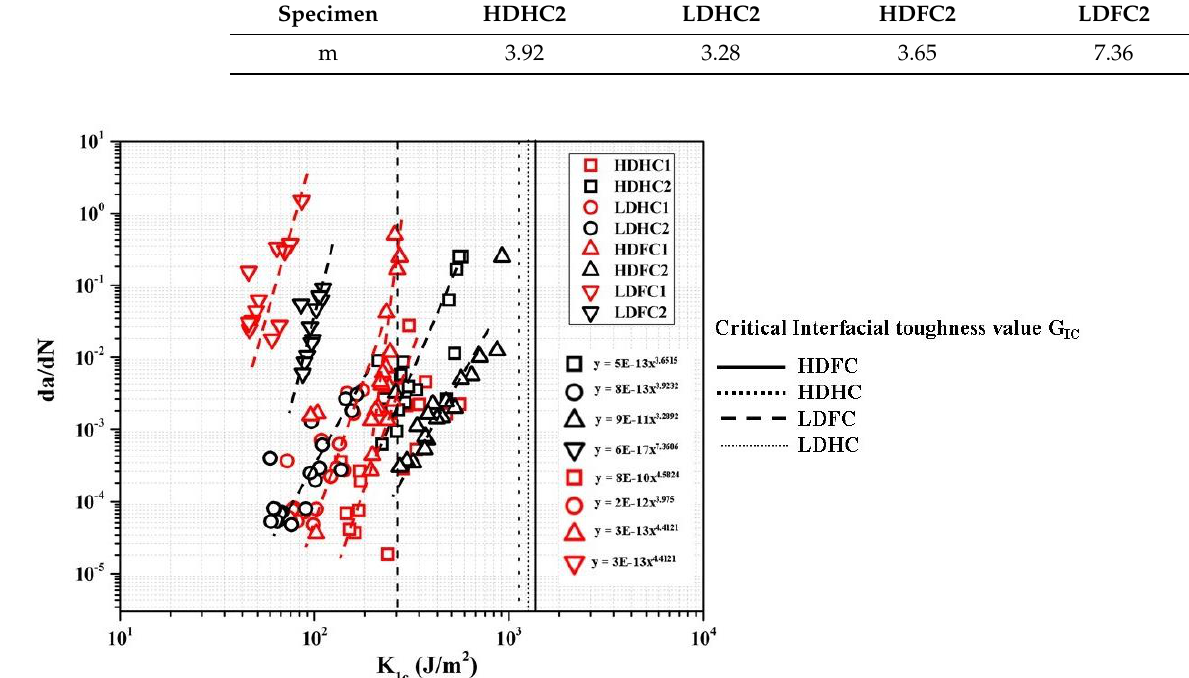
Figure 19. Steady-state crack growth (Paris law) plot for all the tested specimens.